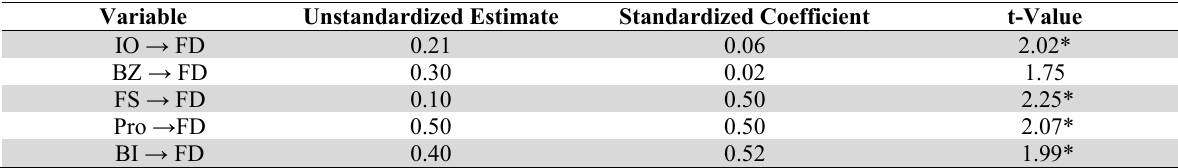
Direct Effect of Institutional Ownership, Board Size, Firm Size, Profitability, Board Independence and Financial Distress